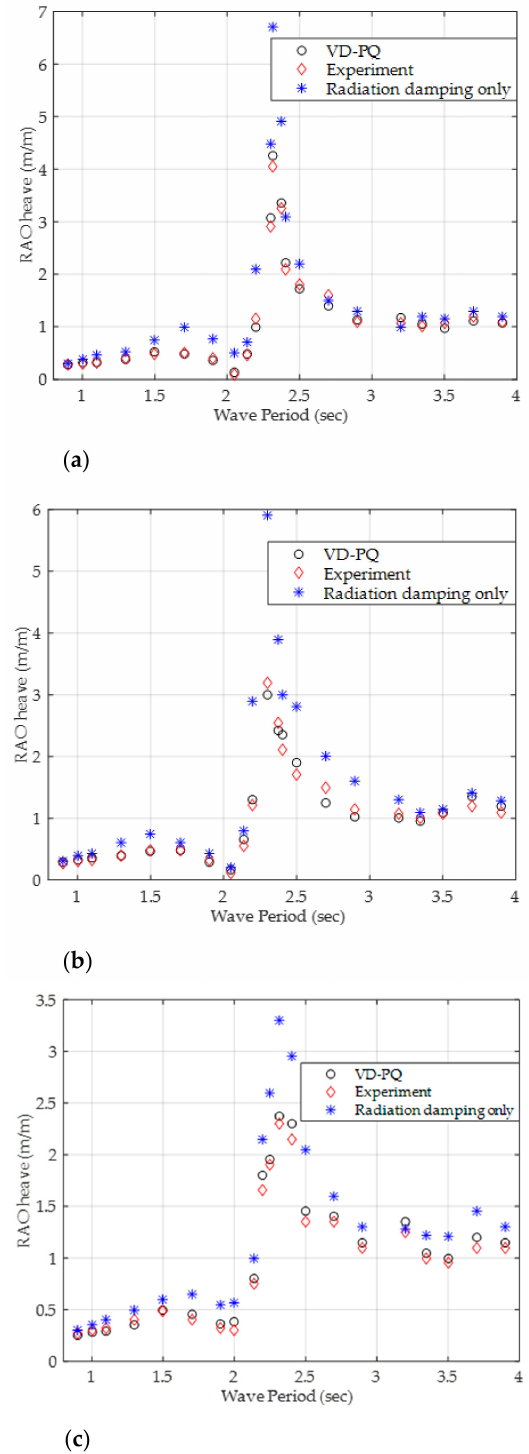
Figure 7. Comparison of heave motion of the examined WEC between experimental data and predictions with use of the velocity-dependent viscous damping model (VD-PQ) and with use of potential theory damping for ( a ) wave height equal to 12 mm, ( b ) wave height equal to 25 mm and ( c ) wave height equal to 75 mm.